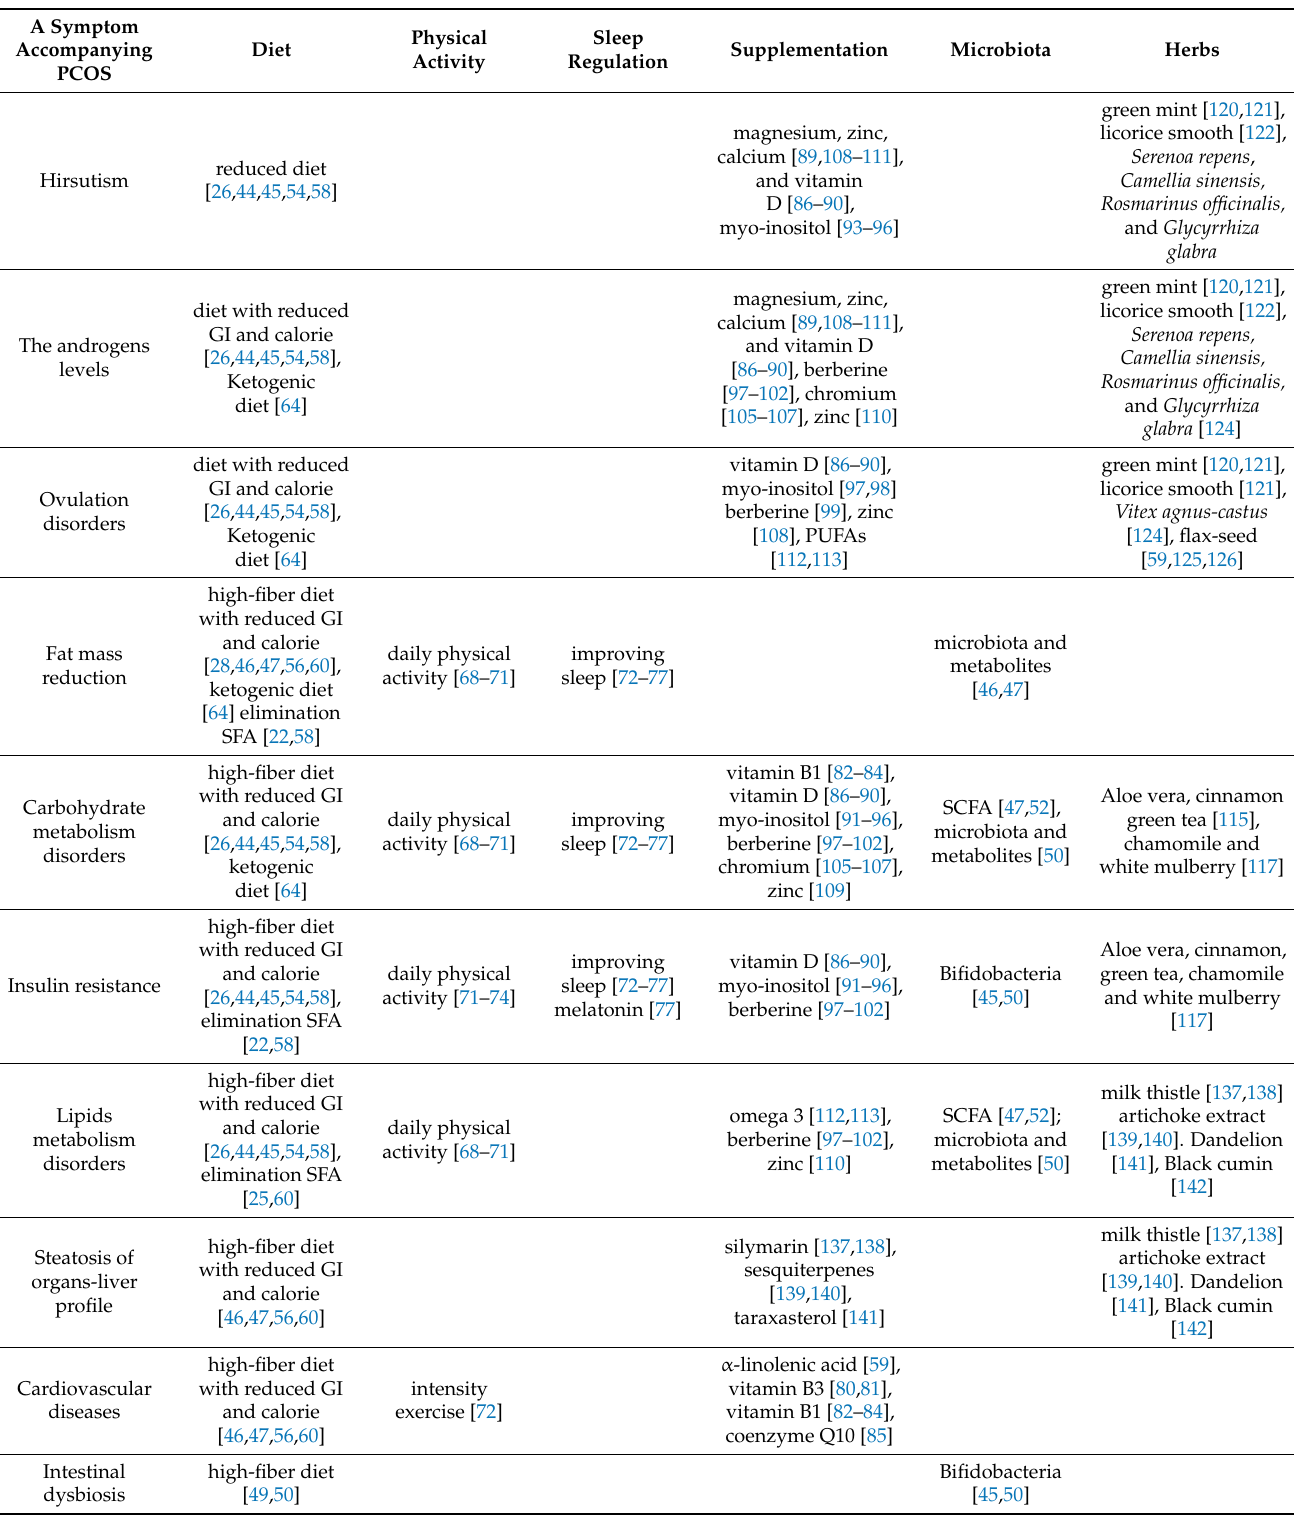
Table 1. Table summarizing described interventions of herbs and their